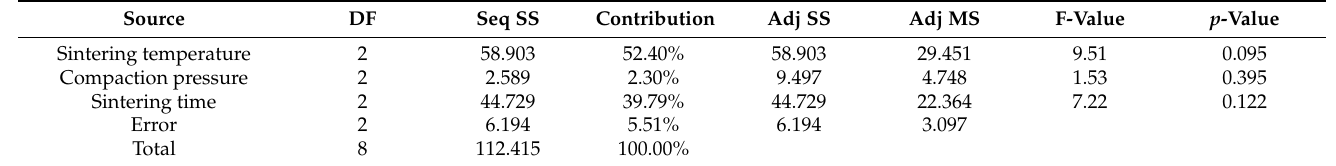
Table 6. ANOVA Variance table for plateau stress.